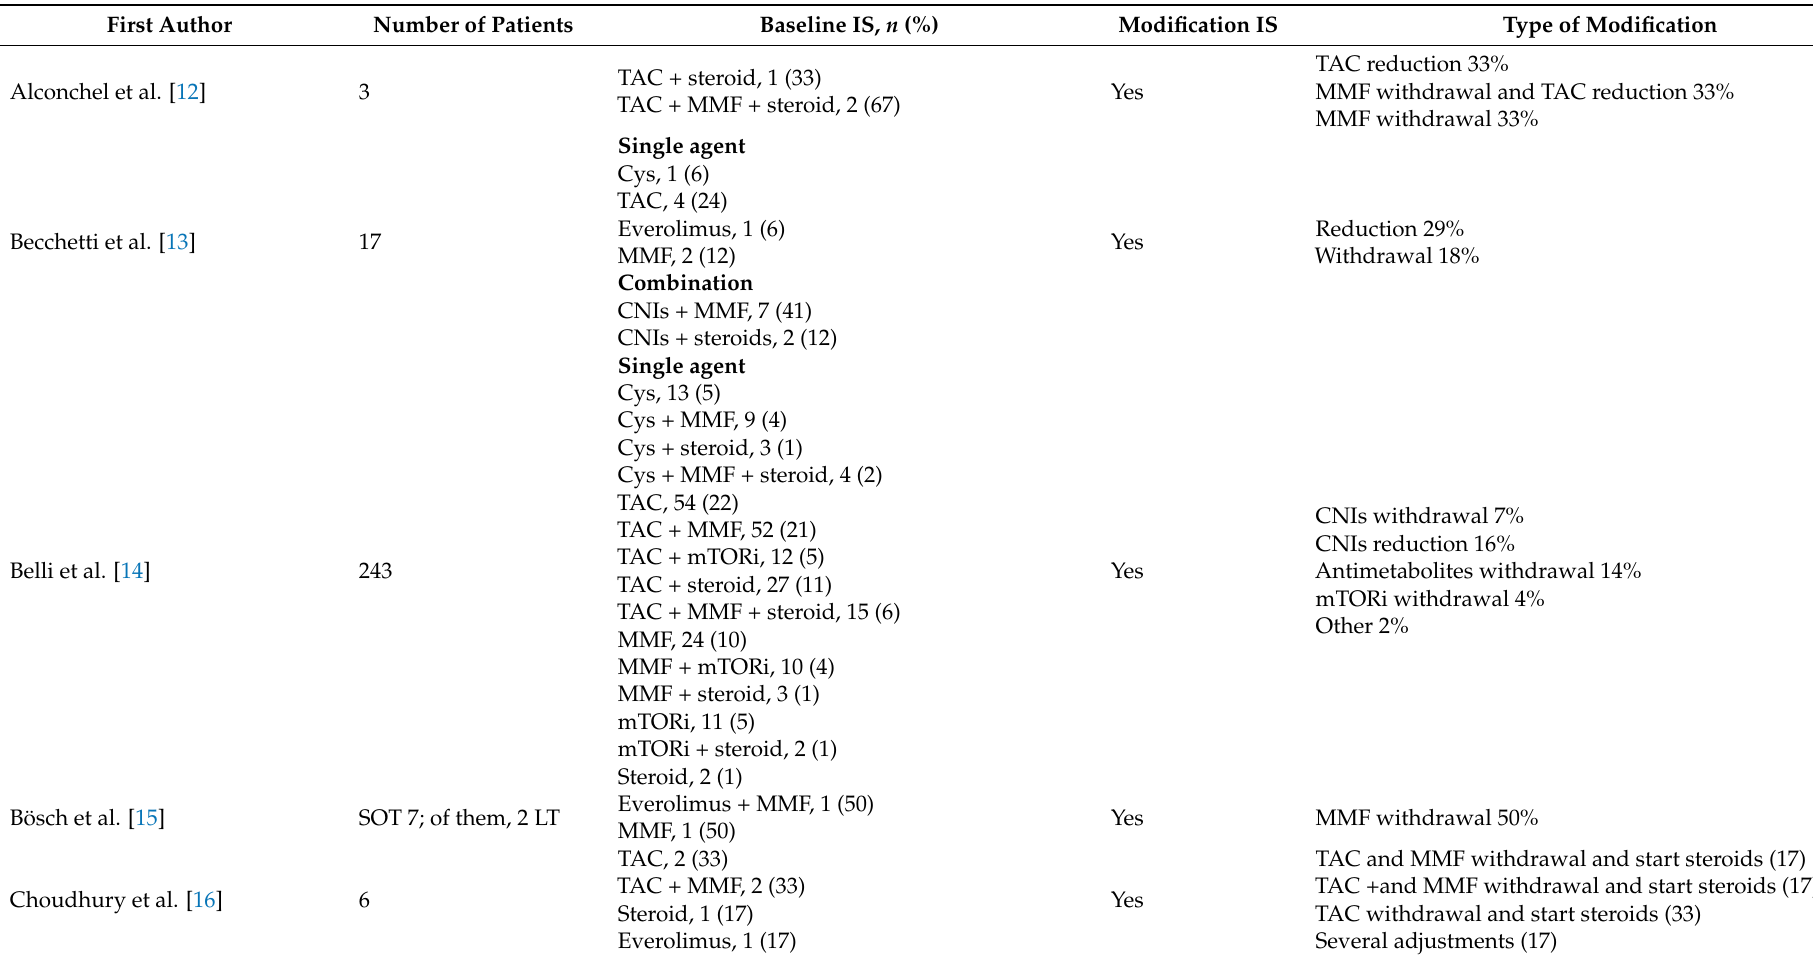
Table 2. Information regarding immunosuppressant regimen and its modification in during